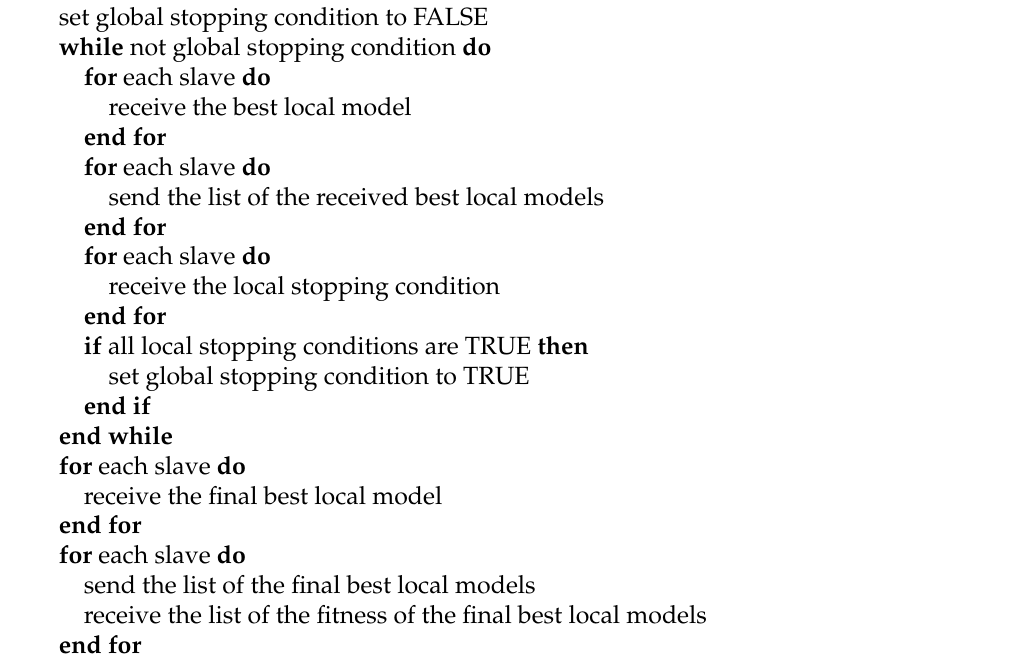
Algorithm 1 Pseudocode of FLEA on the master